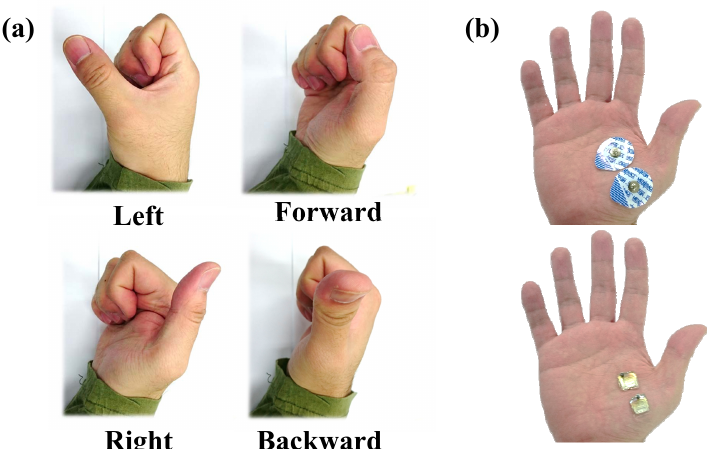
( a ) Configurations of the thumb that were used in motion classification; ( b ) electrode